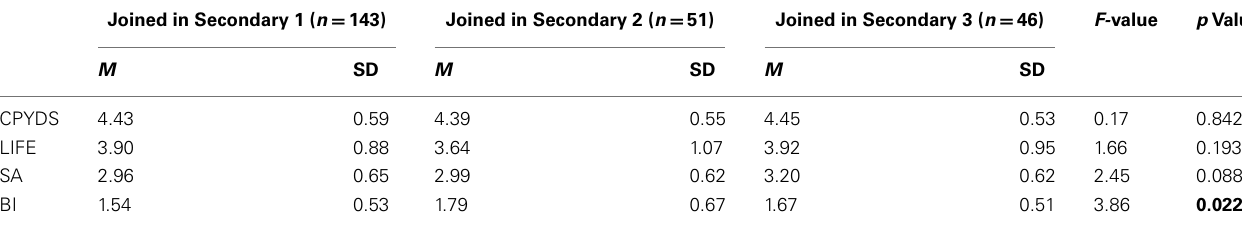
Table 9 |The comparison of objective outcomes based on participating time ( n = 240) . Joined in Secondary 1 ( n = 143)